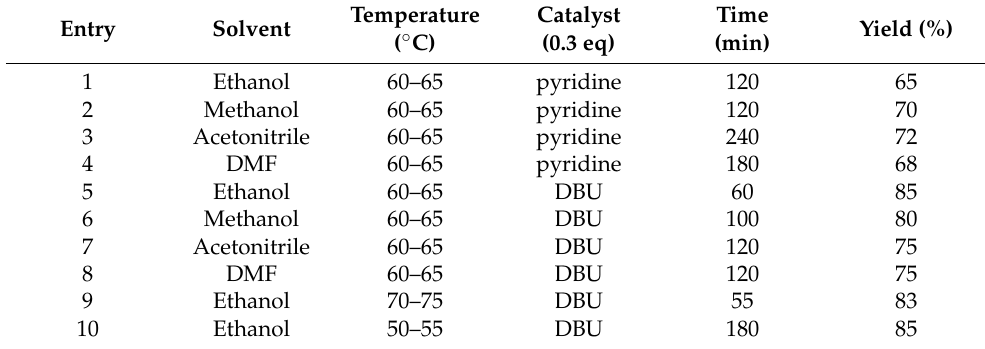
Table 1. Optimization of the model reaction. a.